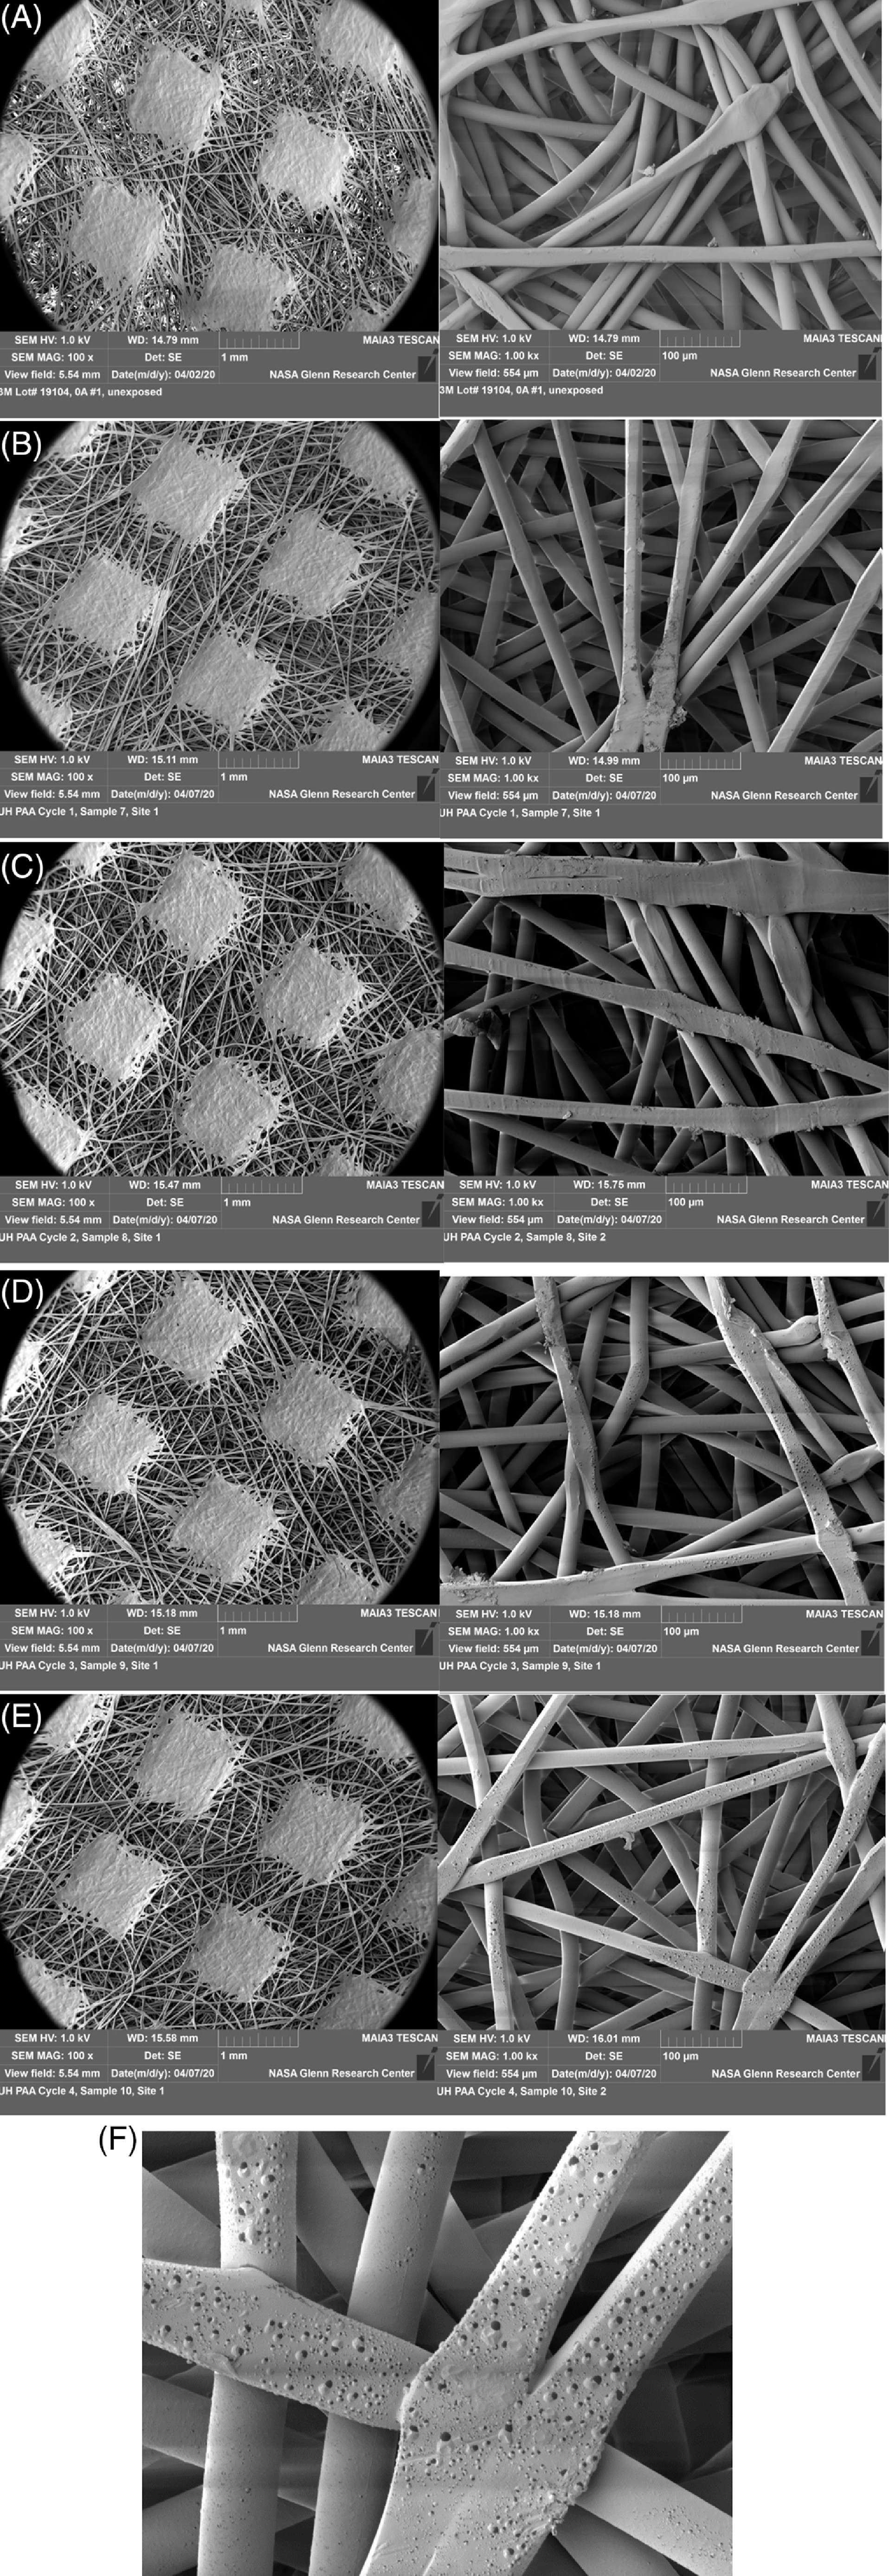
Scanning electron microscope (SEM) images of the outer layer of the N95 mask under 100× (images in the left column) and 1,000× magnification (images in the right column. (A) Control. (B–E) Multiple cycles of PAA treatment from 1 to 4. Note increase bubbling on the fibers after PAA exposure. (F) Magnified image of bubbling on fibers.